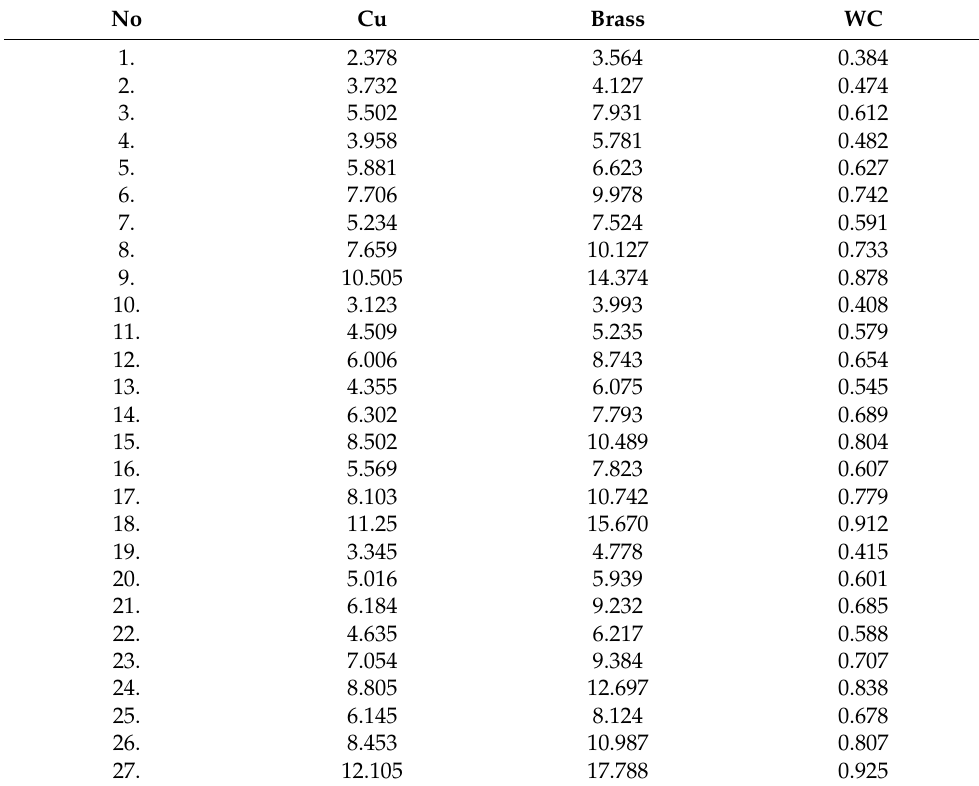
Table 3. Influence of tool electrodes on R a . No Cu